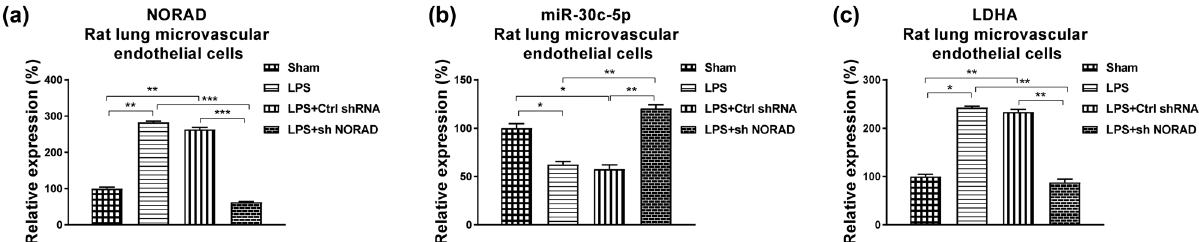
Figure 8: Roles of NORAD - miR - 30c - 5p - LDHA axis in an ALI rat model. ( a ) Control or LPS was injected i.p. to induced ALI in rats 48 h after transfection of control shRNA or sh NORAD. Rat lung endothelial cells were isolated. Expressions of NORAD, ( b ) miR - 30c - 5p and ( c ) LDHA mRNA were examined. *, p < 0.05; **, p < 0.01; ***, p < 0.001.